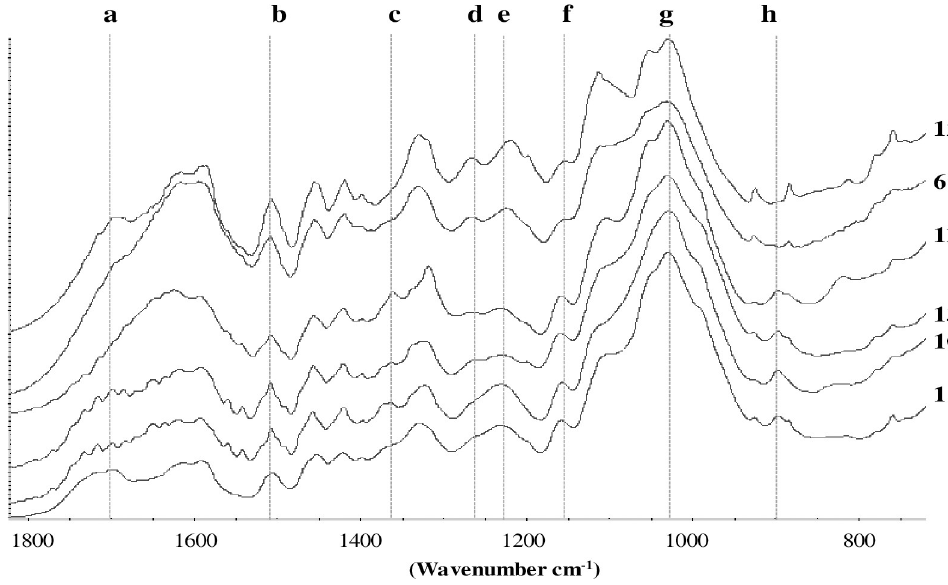
Fig 4. FT-IR spectra (range 1800–700 cm -1 ) for wood samples 1, 10, 13, 11, 6 and 12 along with the main band assignments (in letter) reported in Table 2.